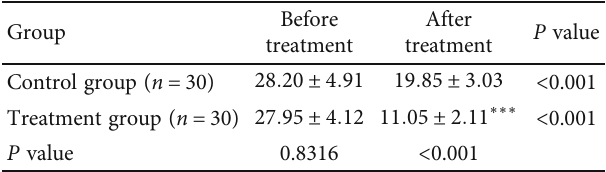
Before After P value treatment treatment